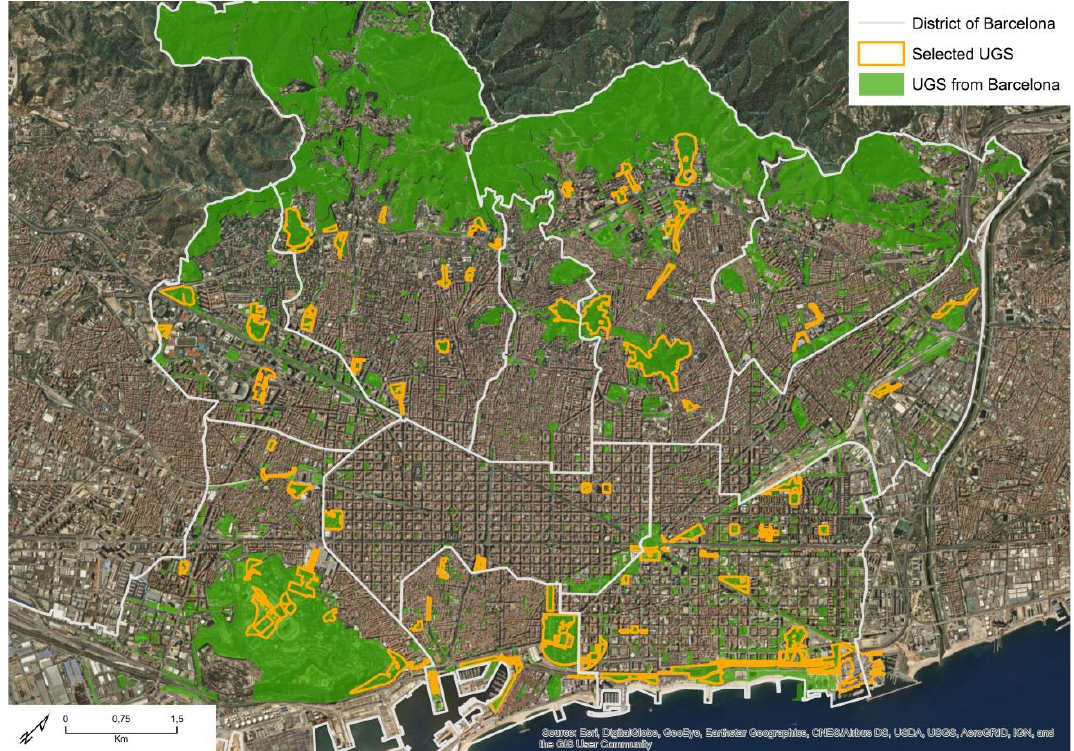
Figure 1. Distribution of UGS available in the city of Barcelona and the analyzed sample. Source: Own production based on ArcGIS © Online base map [51].